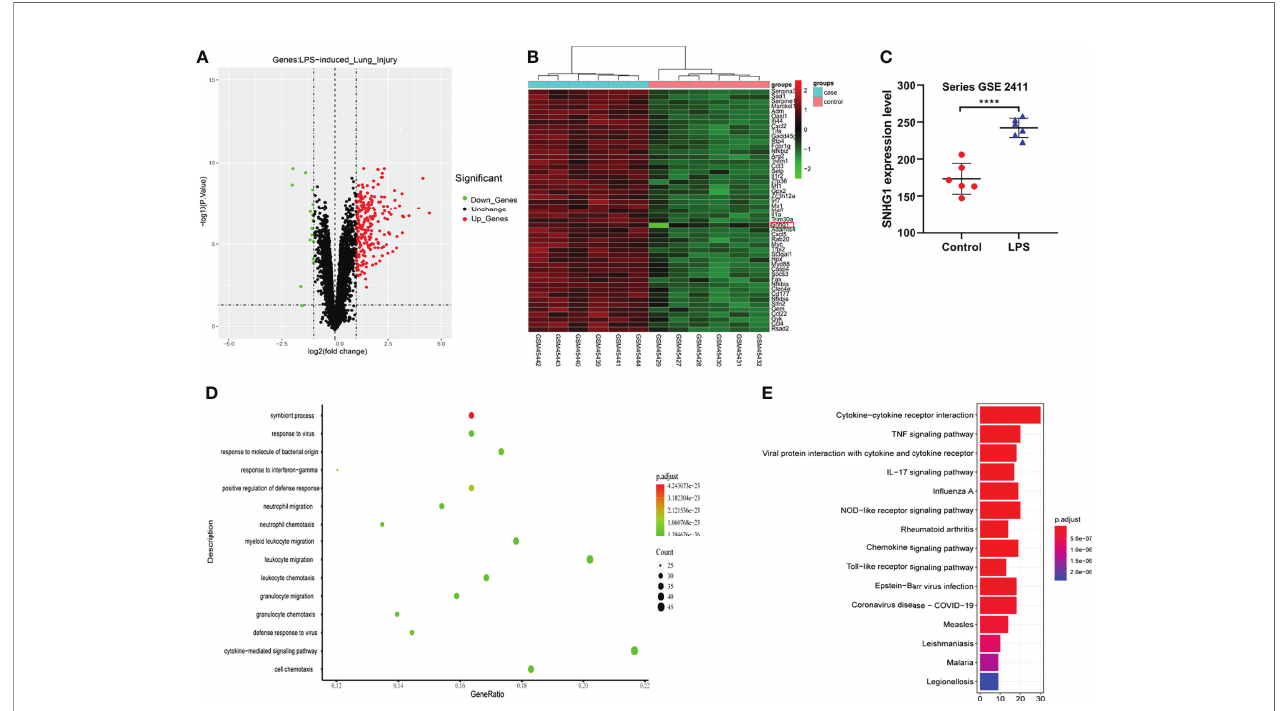
FIGURE 6 | Screening and biological function analysis of DEGs in ALI mice in the GEO database. (A) The expression of upregulated and downregulated genes in ALI mice in a volcano plot. (B) The expression of SNHG1 was upregulated among the upregulated genes. (C) Comparison with the control group. SNHG1 expression in the ALI mouse model. (D) GO function analysis of upregulated genes in the ALI mouse model. (E) KEGG pathway analysis of upregulated genes in the ALI mouse model. Data are indicated as the mean ± SD, **** P